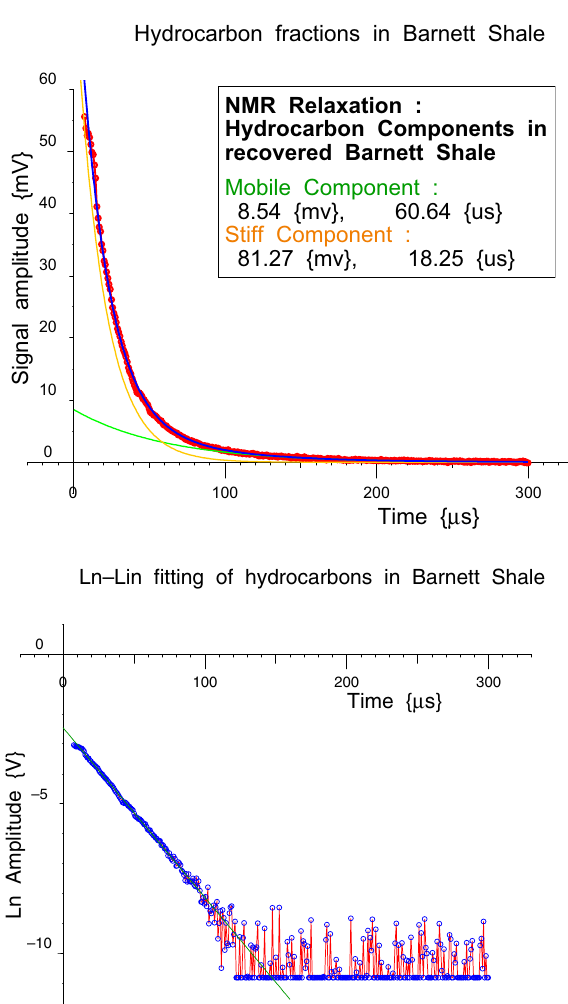
Fig. 14 Again the fitted long-exponential component has been subtracted from the data. The resultant straight line in the log- domain plot clearly demonstrates that the short component is also an